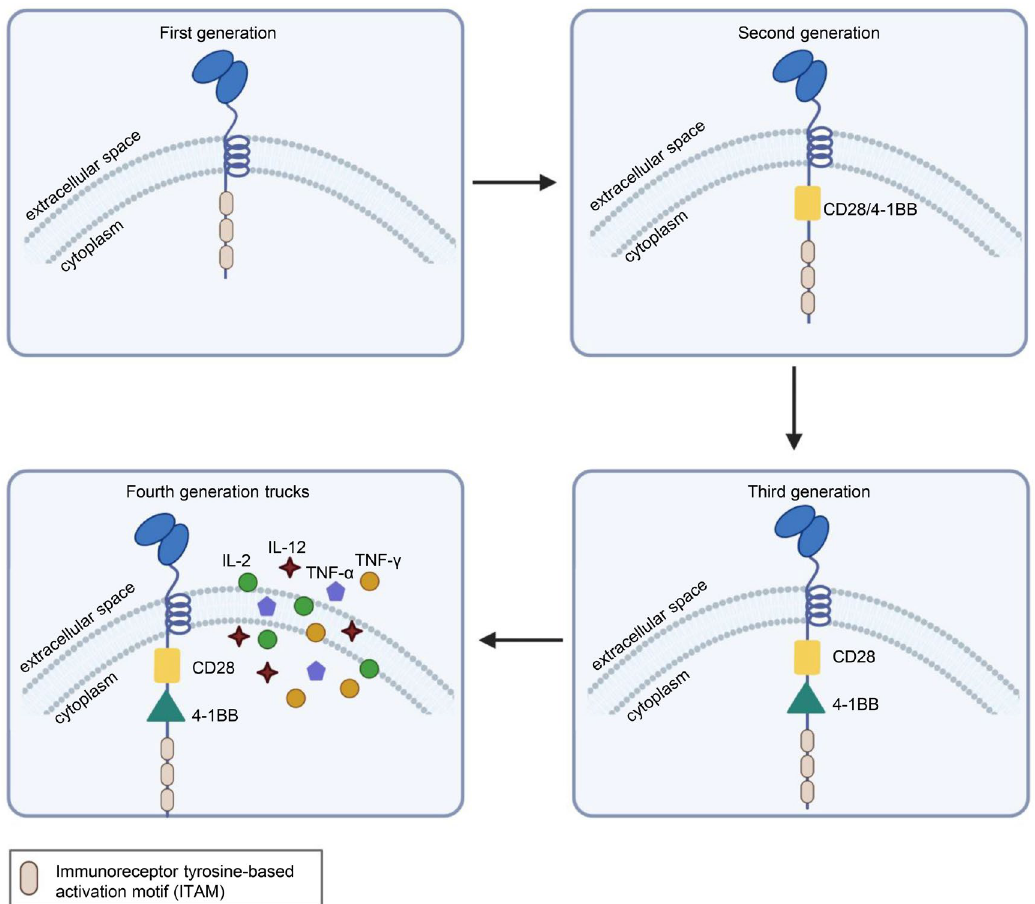
Figure 2. Structural differences in the four generations of CARs. First-generation CARs had only CD3ζ as the intracellular signaling domain. Second-generation CARs contain CD3ζ and a costimulatory domain, which may be CD27, CD28, CD137 (4-1BB) or OX40. Third-generation CARs contain CD3ζ and two costimulatory domains, such as CD28 and CD137 (4-1BB), or other costimulatory molecules. On the basis of the third generation, the latest fourth-generation CARs can additionally secrete cytokines or other effector molecules, such as IL-12, IL-15, IL-7, CCL19 or αPD-1, to modulate the tumor immune microenvironment. Illustration was created with Biorender.com.